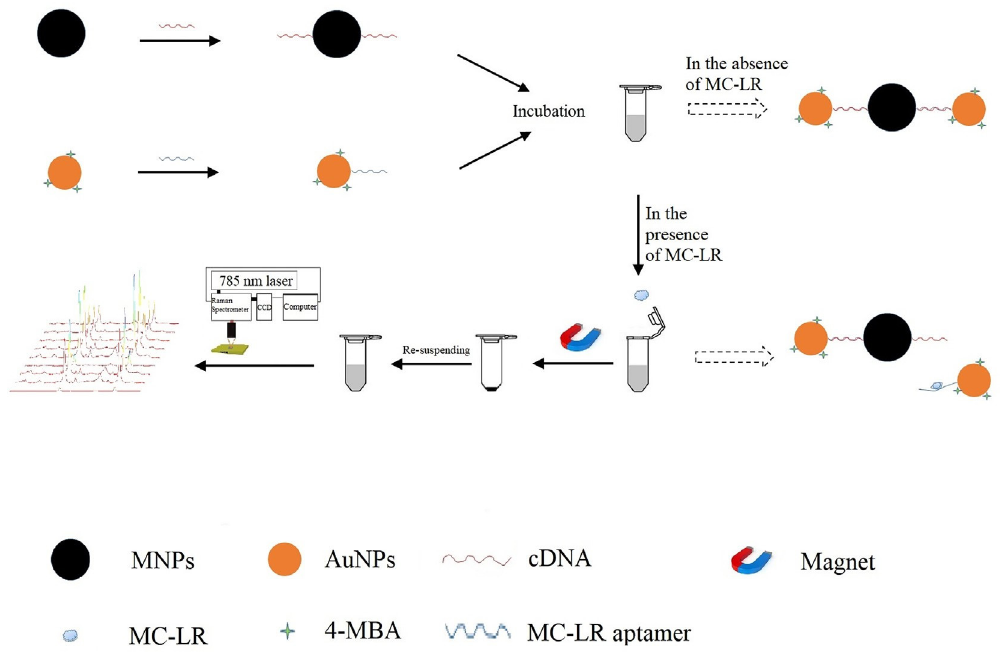
Figure 3. Illustration of the principle for the analysis of microcystin-LR (MC-LR) based on the SERS-based aptasensor. Reprinted [72] © 2019, with permission from Elsevier.